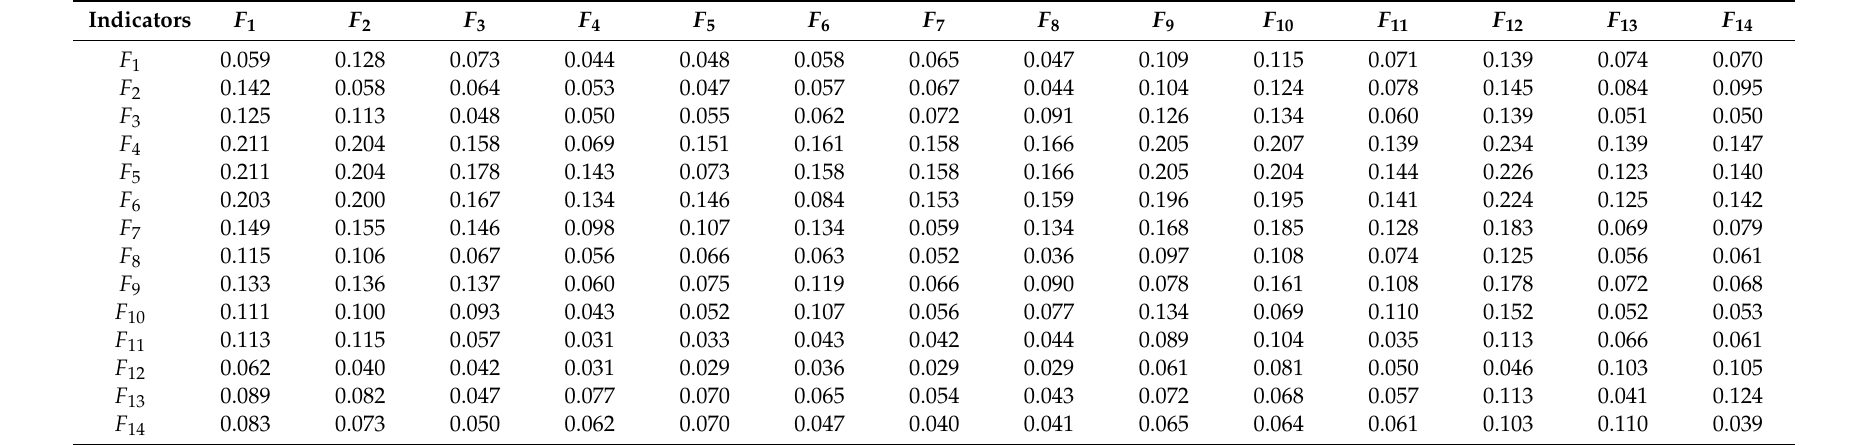
Table 6. The total influence matrix T